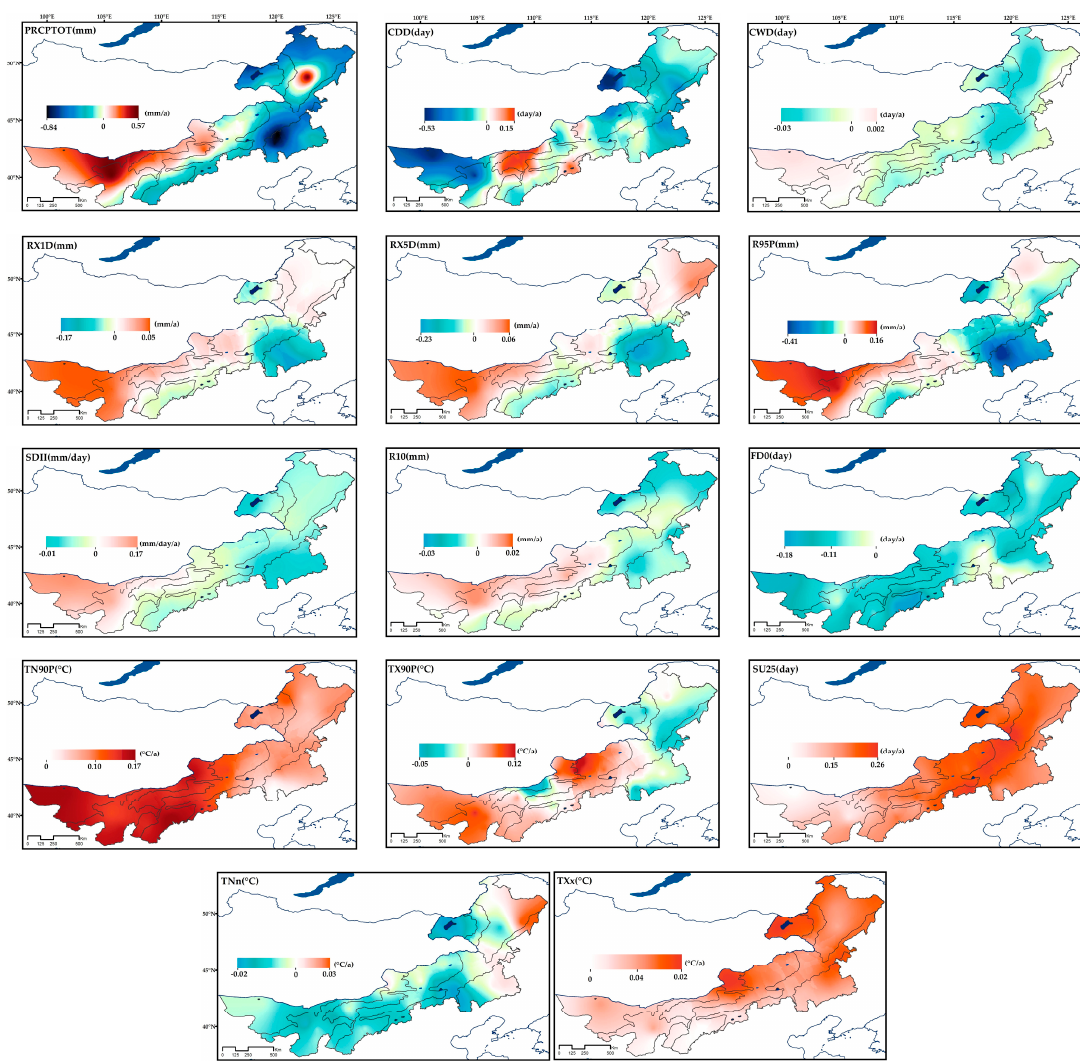
Figure 3. Spatial distribution of extreme climate indices changes in different vegetation types during 1982–2015.